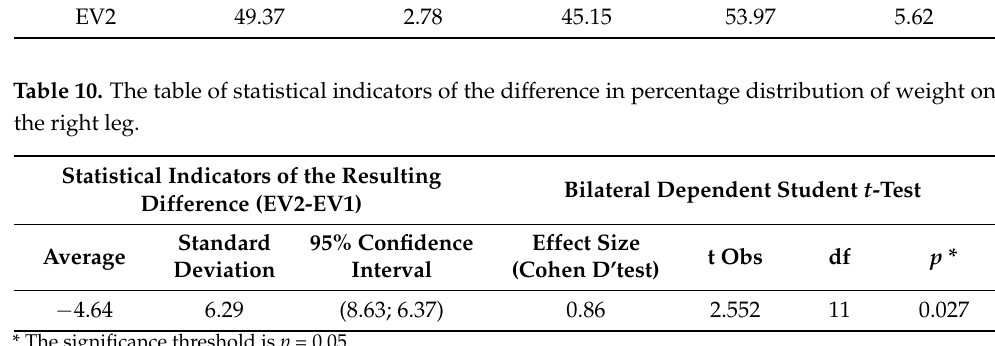
and second evaluation of the subjects of the experimental group (N = 12). second evaluation of the subjects of the experimental group (N = 12).